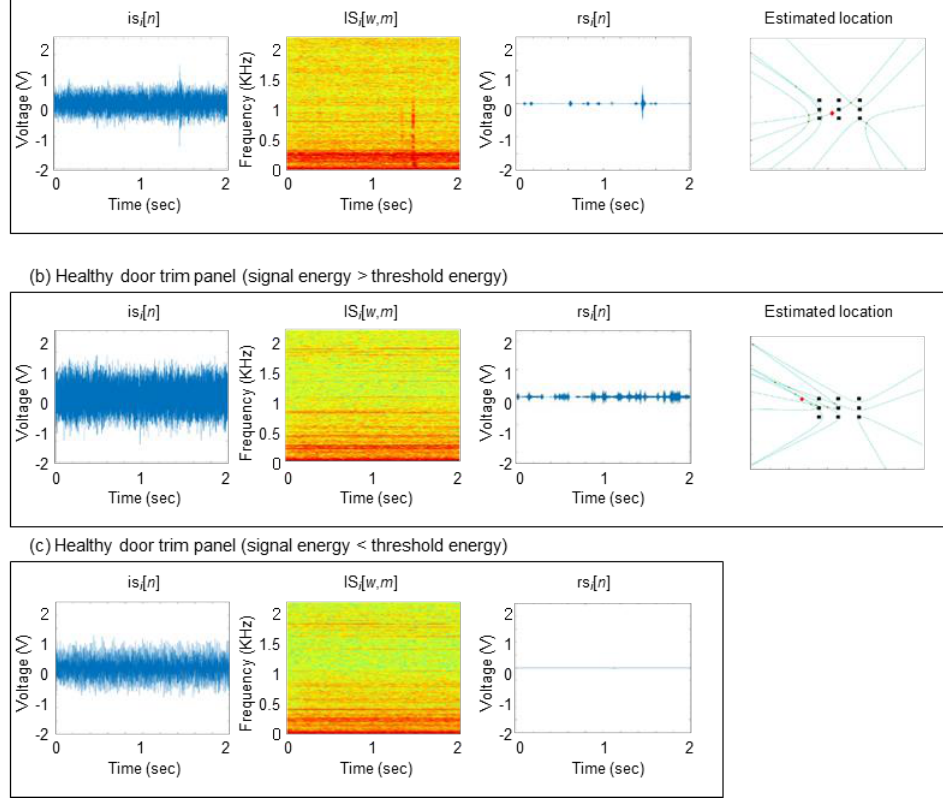
Figure 8. Three examples of noise inspection results: ( a ) correct determination of a faulty car door trim panel ( b ) correct determination of a healthy panel when the energy of rs i [ n ] exceeds the threshold energy ( c ) correct determination of a healthy panel.